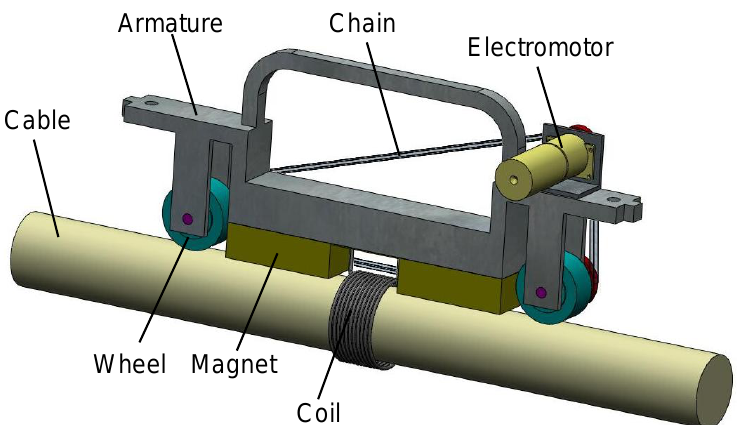
Figure 9. Structure of the climbing module.